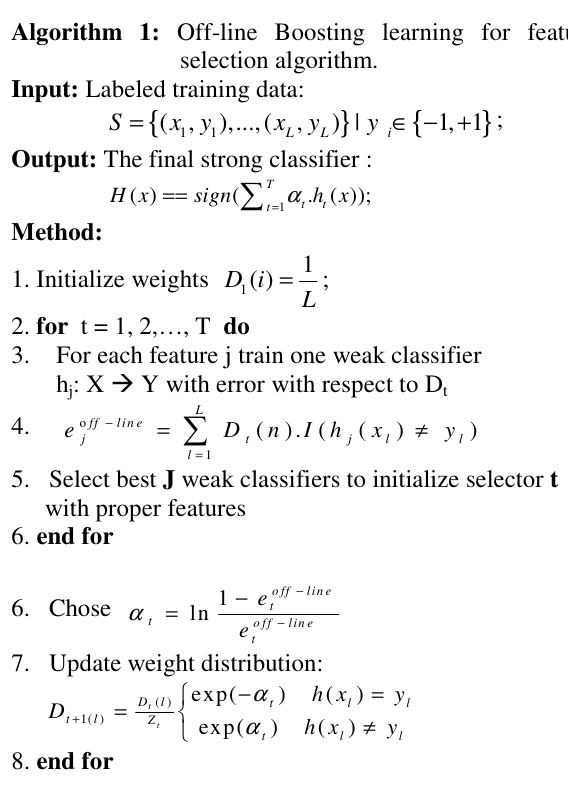
Algorithm 1: Off-line Boosting learning for